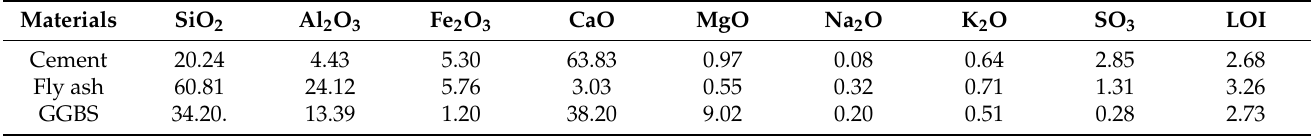
Table 1. The chemical compositions of the binder materials